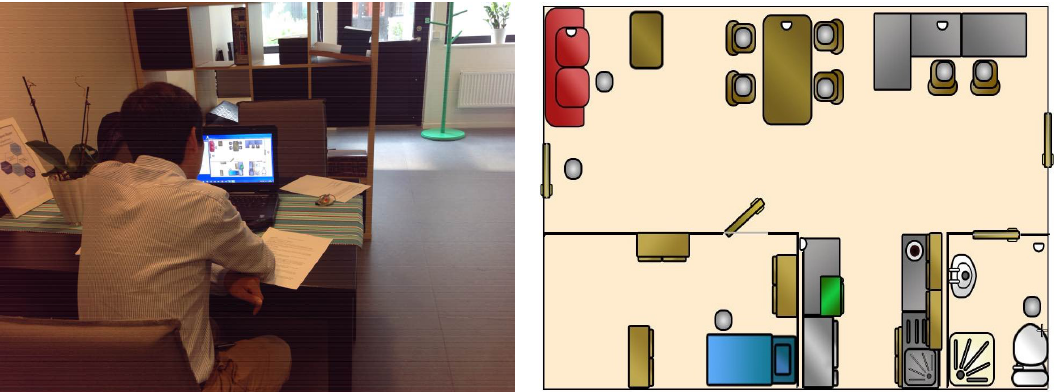
Figure 2. ( Left ) User during the first simulation test with IE Sim. ( Right ) The virtual representation of HINT environment designed within IE